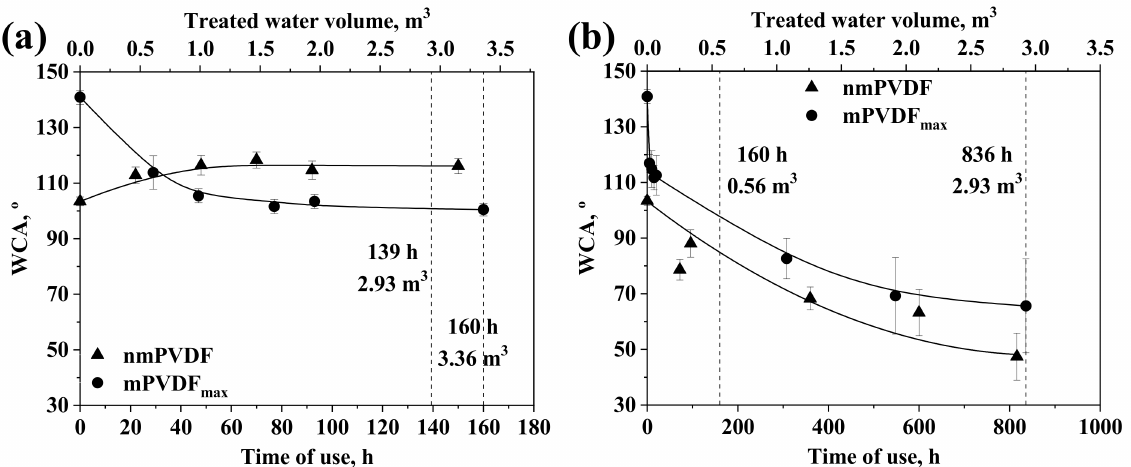
Figure 7. Water contact angle versus time of use (bottom axis) and volume of treated water (top axis) for non-modified PVDF (nmPVDF) and PVDF modified under optimal conditions (mPVDF max ) with ( a ) deionised water at a liquid flow rate of 21 L h − 1 and ( b ) anaerobic reactor effluent at a liquid flow rate of 3.5 L h − 1 . Data on nmPVDF with deionised water from [8]. The error bars denote the standard